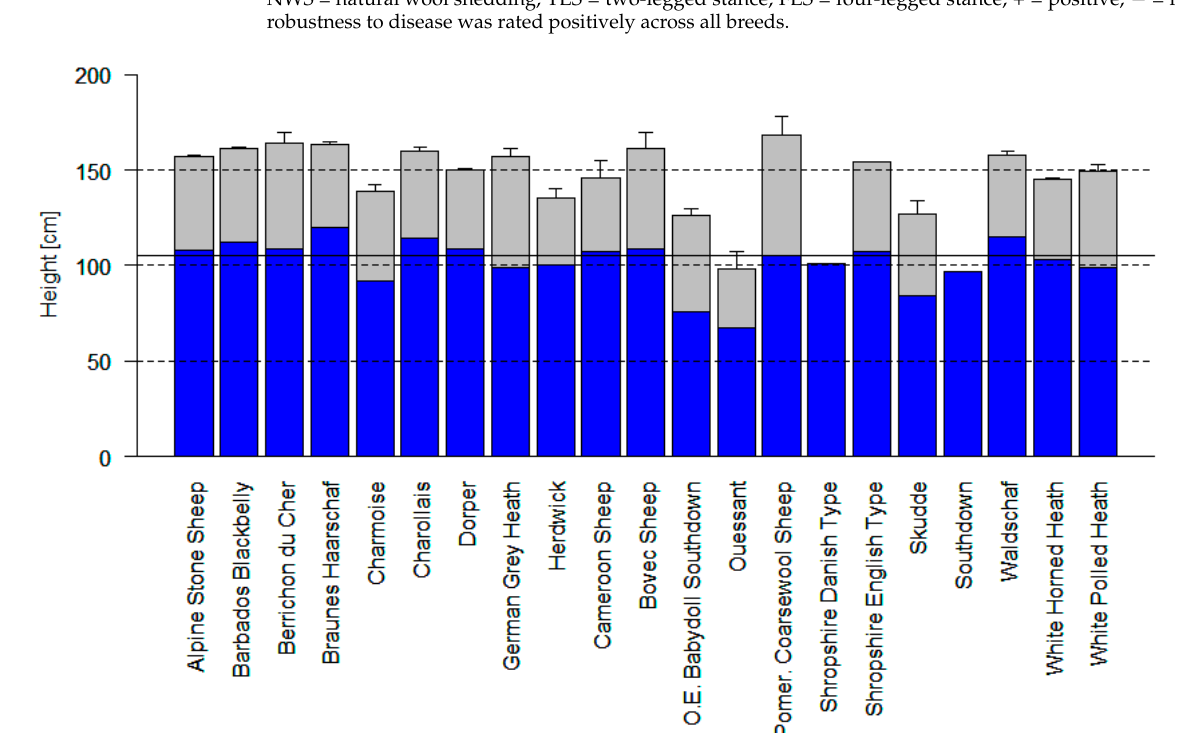
Robustness reflects the breeders’ assessment of resistance to weather conditions, hoof constitution and fertility. Mean and median differ by a maximum of 1 cm. Taking into account individual ana- tomical differences, an interpretation of the max. height of the muzzle must recognize additional height spans: for the two-legged stance approx. +/ − 10 cm and for the four-legged stance approx. +/ − 5 cm. LU = livestock unit of the average weight of an ewe (conversion of 85 kg is 0.15 LU); N = number of sheep measured; N/A = not available; NWS = natural wool shedding; TLS = two-legged stance; FLS = four-legged stance; + = positive; − = negative; robustness to disease was rated positively across all breeds.